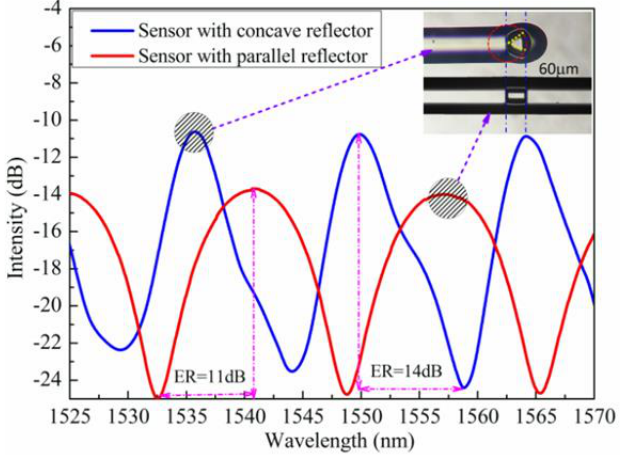
Figure 7. Experimental spectrum of the microcavity interference (blue line is the interference spectrum of the sensor with concave reflector; red line is the interference spectrum of the sensor with parallel reflector; ER: extinction ratio)